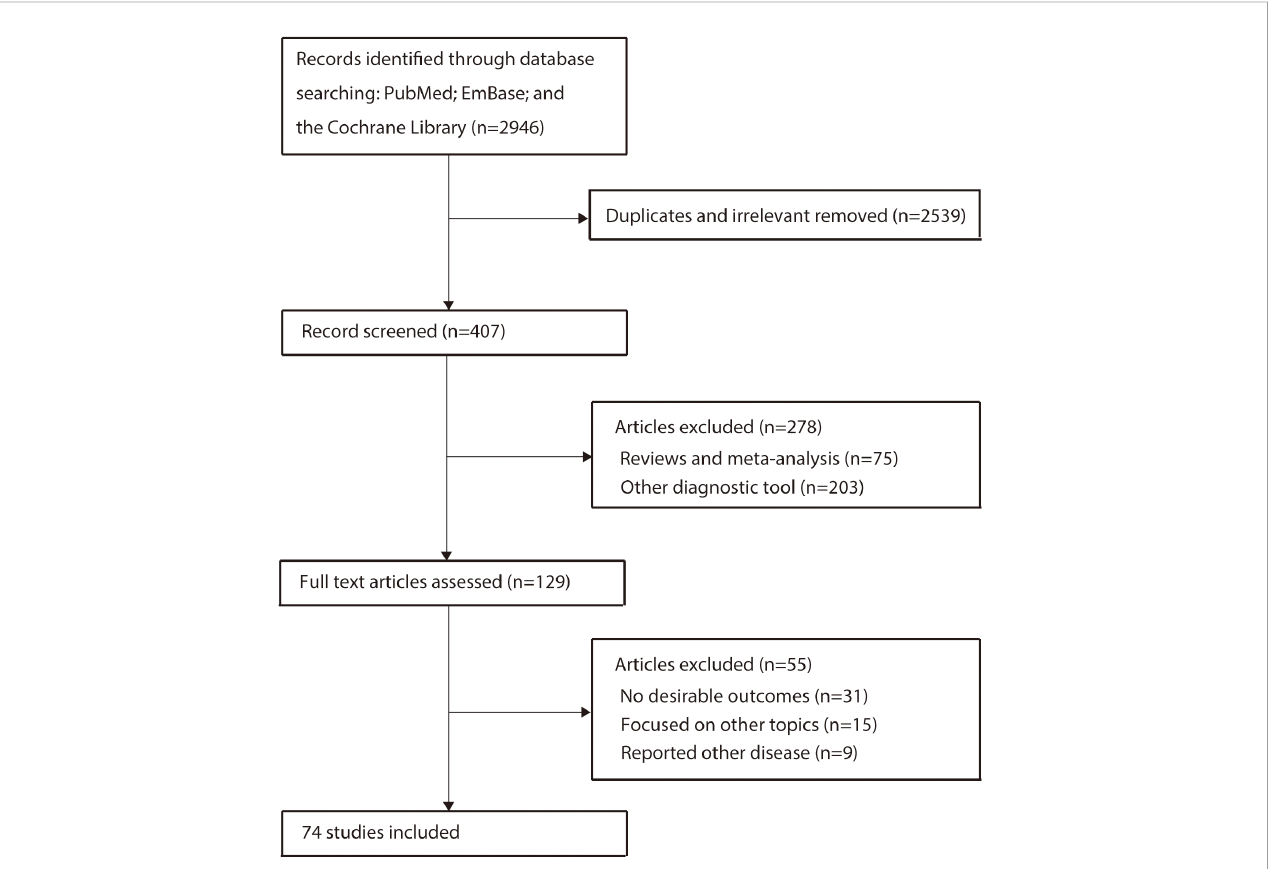
FIGURE 1 Flow diagram of the study selection